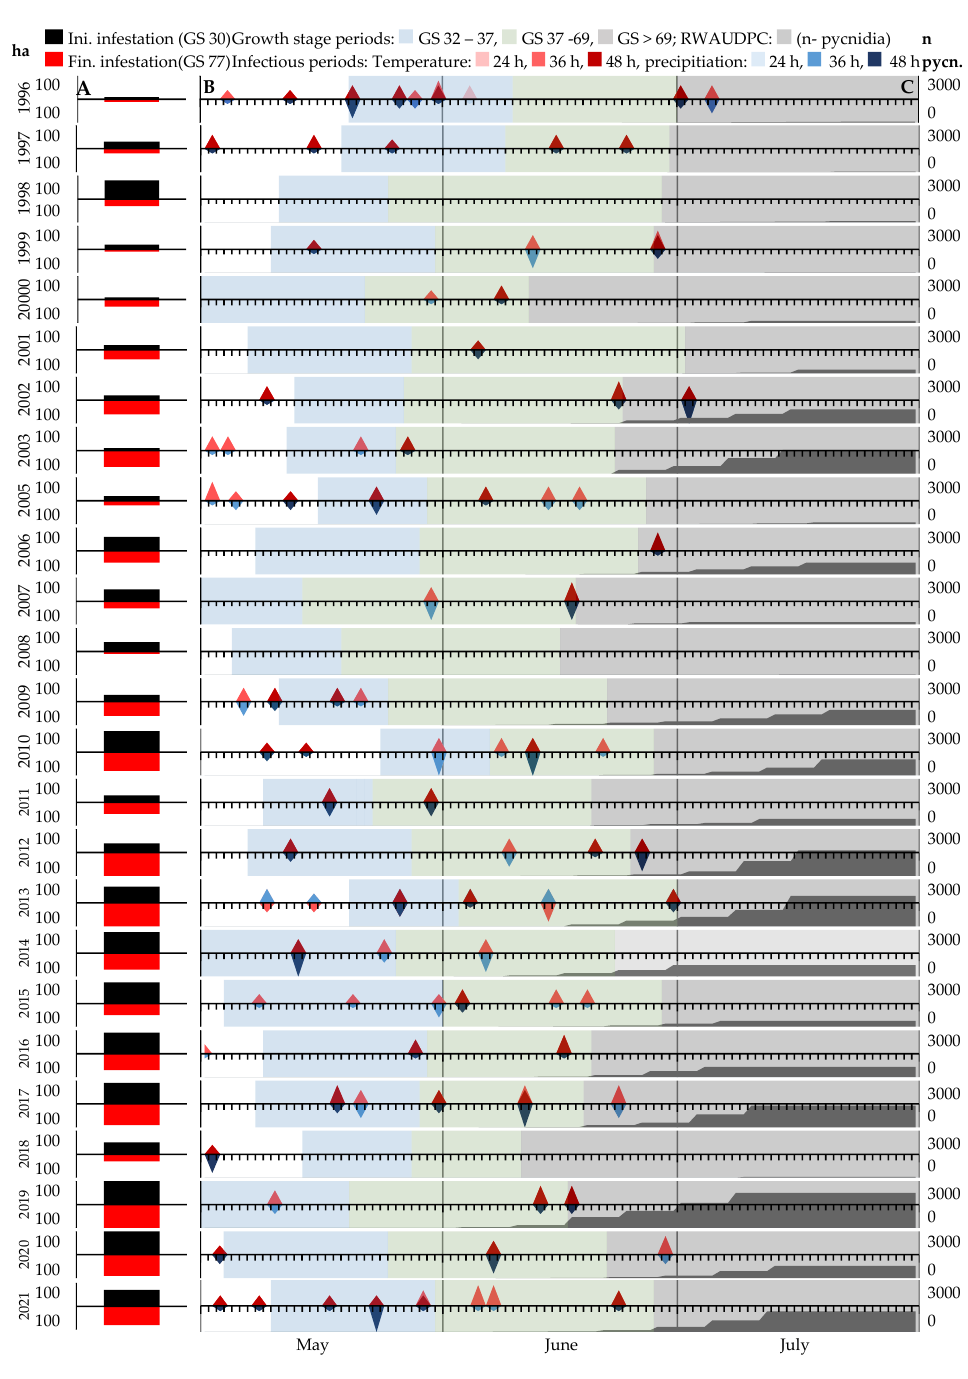
Figure 5. ( A ) Initial (Ini.) infestation and final (Fin.) infestation of STB at the trial location of every year of the survey. ( B ) Temperature (red) and precipitation (blue) during leaf wetness periods over 24 h (light), 36 h (medium), and 48 h (solid) in four categories (temperature < 5 °C, 5–10 °C, 10–15 °C, and 15–20 °C; precipitation <4 L/m 2 , 4–8 L/m 2 , 8–12 L/m 2 , 12–16 L/m 2 , and 16–20 L/m 2 ), and ( C ) disease severities of STB (grey area) in combination with plant growth stages from the months May, June, and